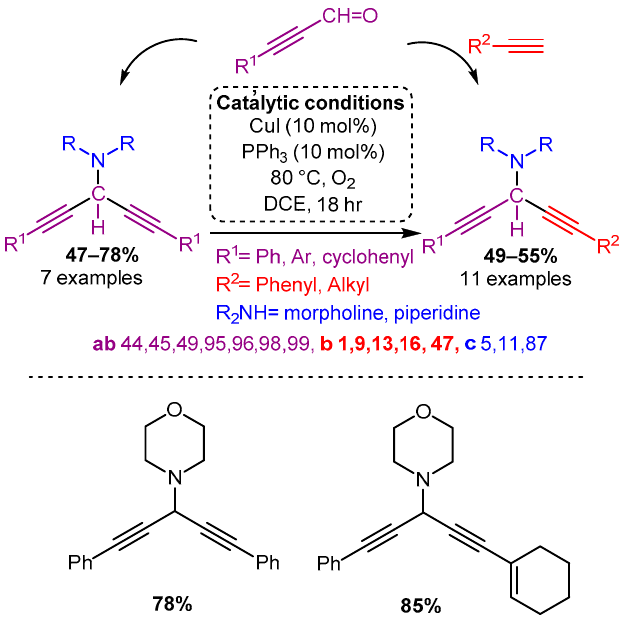
Scheme 9. Formation of monocyclic oxazolidines from chiral amino